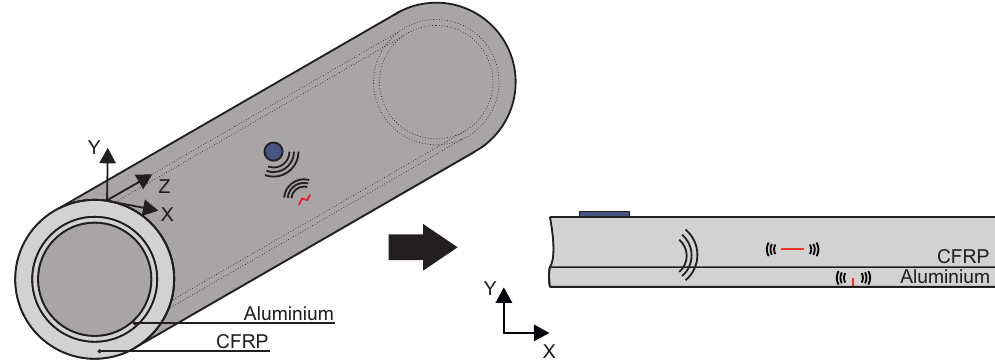
Figure 2. Sketch of a simplified structure of a COPV with corresponding sensor placement, adapted from